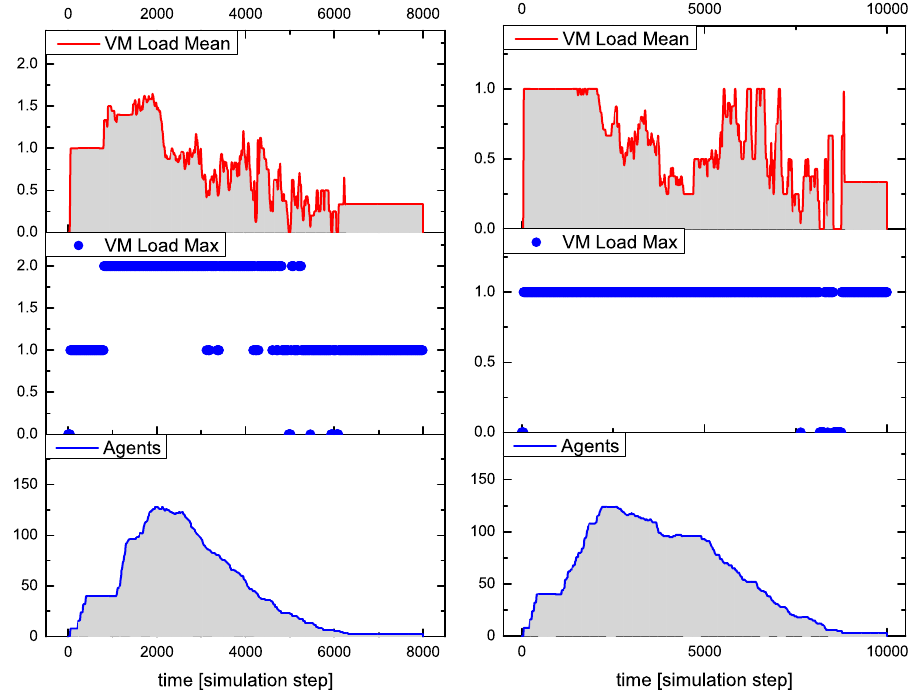
Figure 10. Analysis results with two VMs ( left ) and only one VM ( right ) per node (the feature is recognized after 6200 and 8800 simulation steps, respectively) (load: the fraction of processing to the idle time of a VM